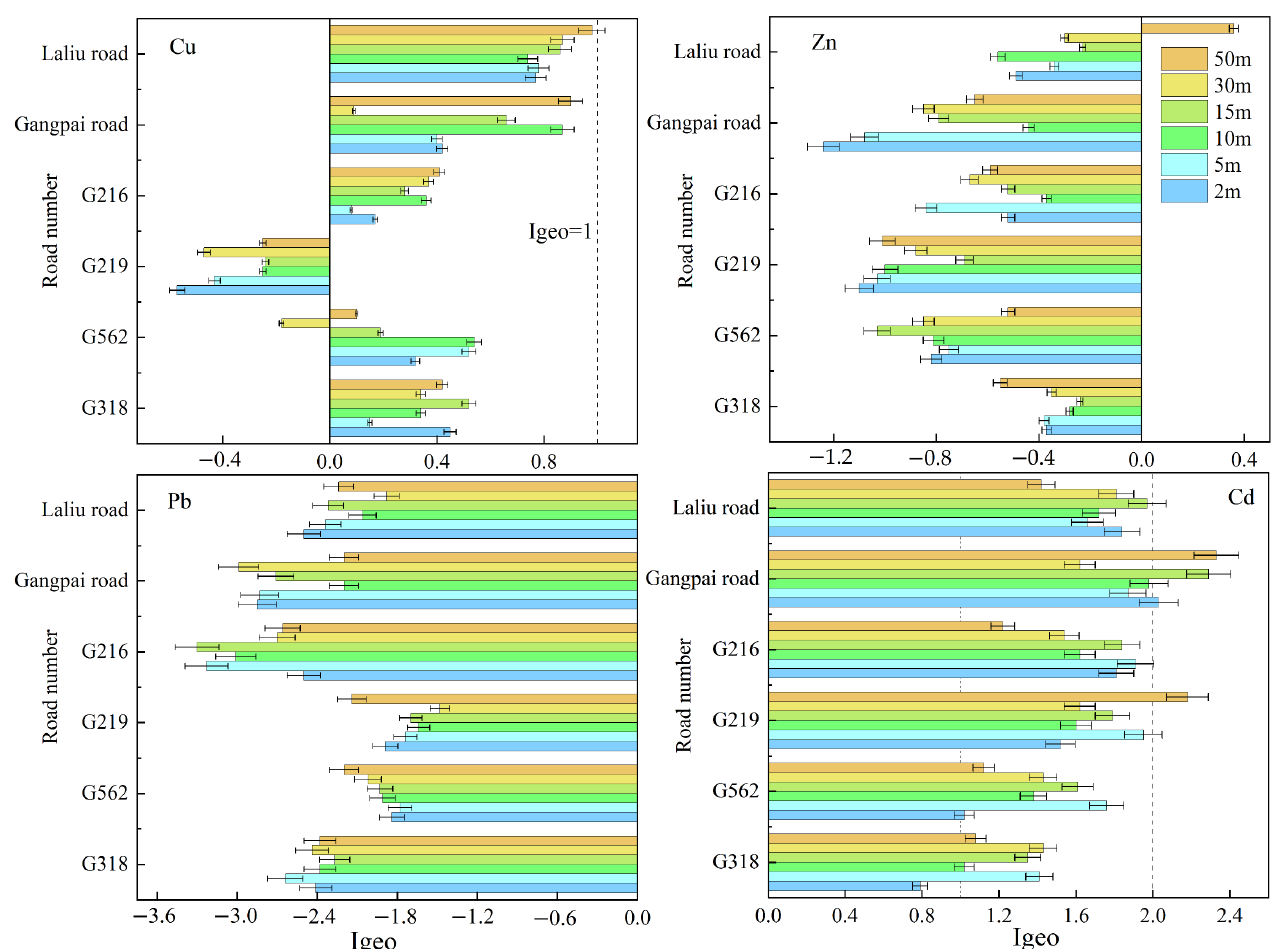
Figure 4. Geoaccumulation index of soil heavy metals at different distances from each road.